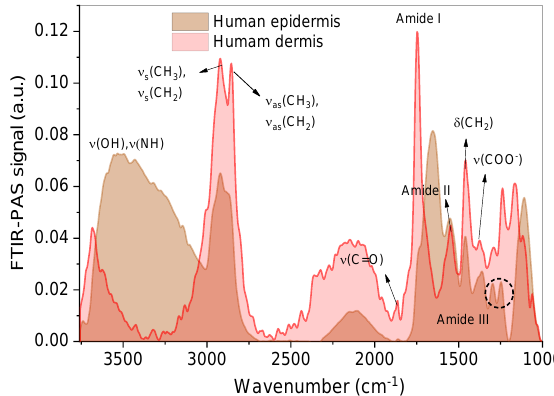
Figure 7. FTIR-PAS absorption spectra for human skin. Note: vibrations— ν : stretching (symmetric or asymmetric) and δ: angular deformation.